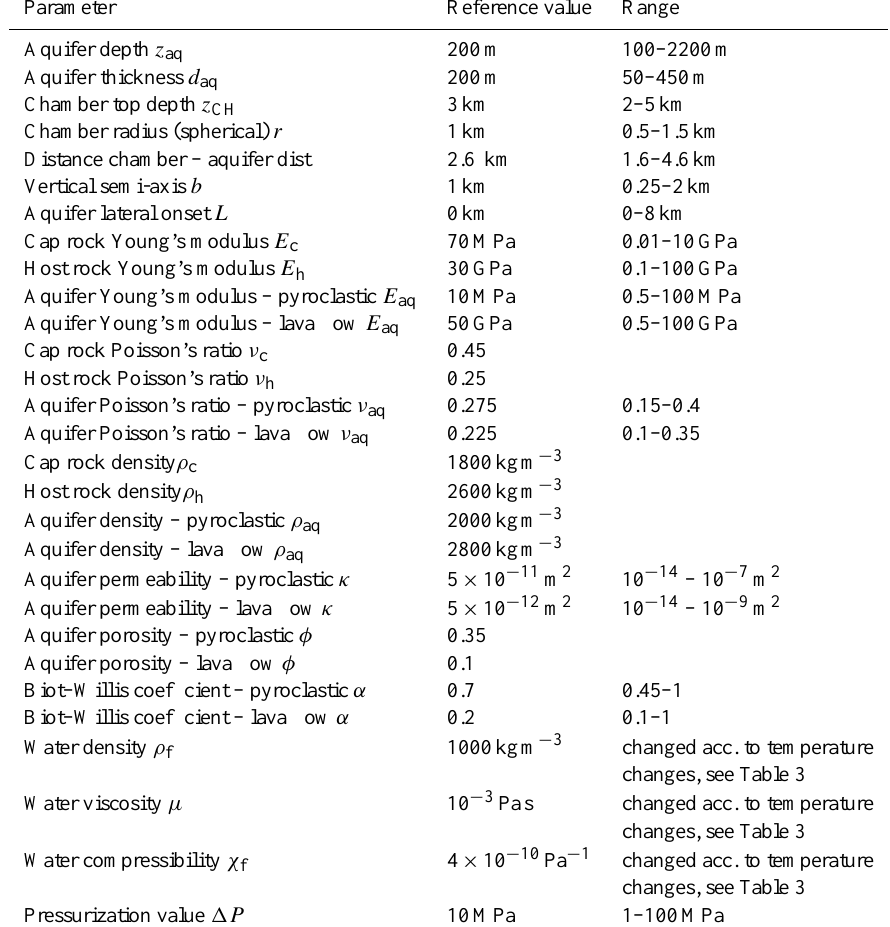
Table 2. Input parameters: reference values and ranges for parametric studies (where